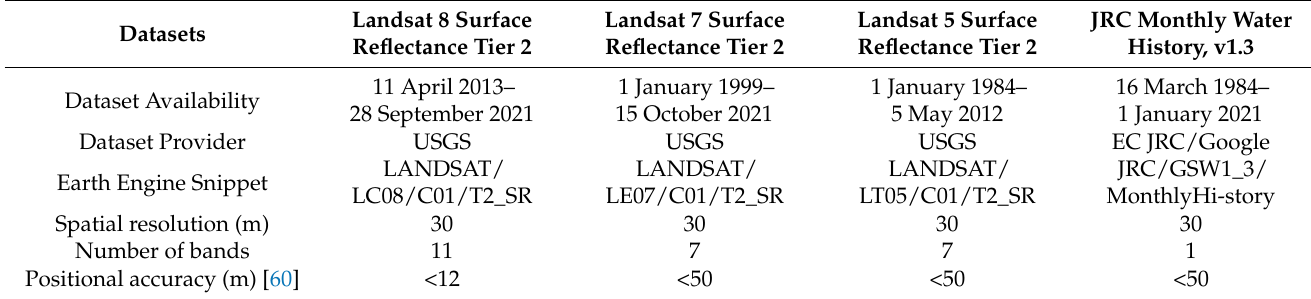
Table 2. Description of L8SRT2, L7SRT2, L5SRT2, and JRC